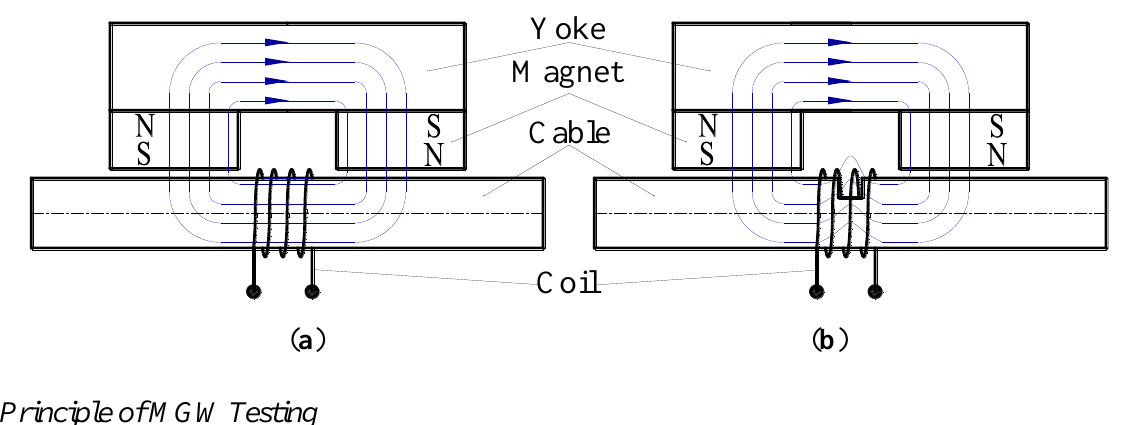
Figure 3. Principle of MFL testing. ( a ) Undamaged cable; ( b ) Cable with metal